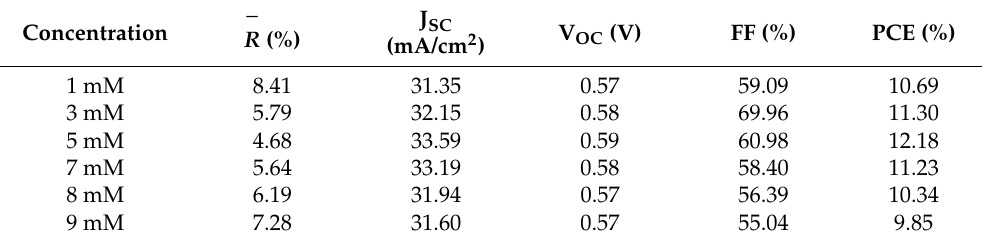
¯ R (%) of silicon solar cells fabricated using different